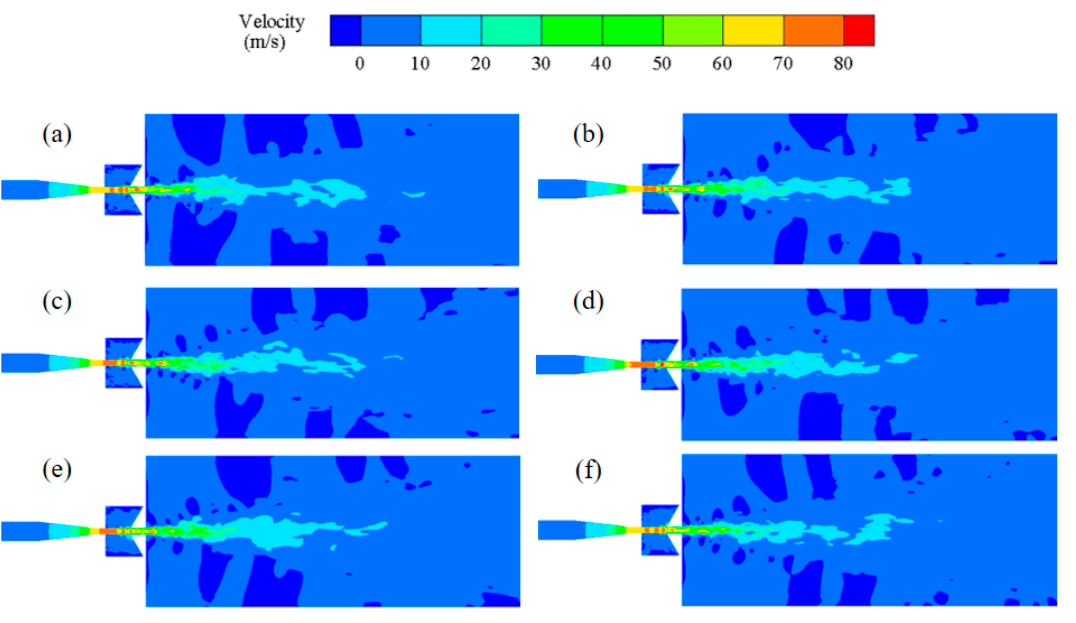
Figure 6. Velocity contour of SEOPJ at different time ( Δ t = 5 ms) ( a ) t = t 0 + Δ t ; ( b ) t = t 0 + 2 Δ t ; ( c ) t = t 0 + 3 Δ t ; ( d ) t = t 0 + 4 Δ t ; ( e ) t = t 0 + 5 Δ t ; ( f ) t = t 0 + 6 Δ t .